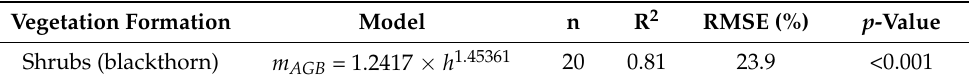
Table 2. Allometric model for quantifying above-ground woody biomass of shrubs on abandoned agricultural